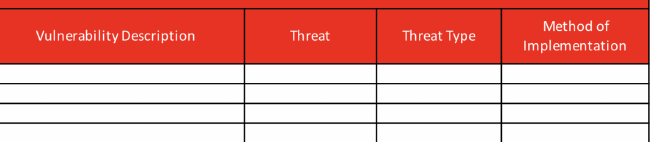
Figure 3. Phase 2 Template: Identify Threats to the infrastructure that uses this Technology. Phase 3: Categorize Threats to Determine Risk. In this phase of the process the threats are categorized into greater detail to help determine the level of risk they can impose against the vehicle network. The template in Figure 4 is developed for this phase. The information that is collected in this phase is used to determine the likelihood of the threat’s initiation and impact. The target of the attack, historical information about the threat, and the amount of resources and expertise required to make a threat scenario possible are taken into consideration. Below, we present the factors that need to be considered in this